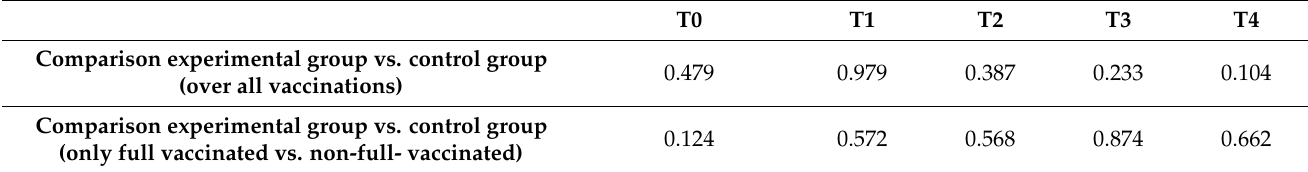
Table 4. Results of the chi 2 -test for significant changes between the two groups for T0–T4.